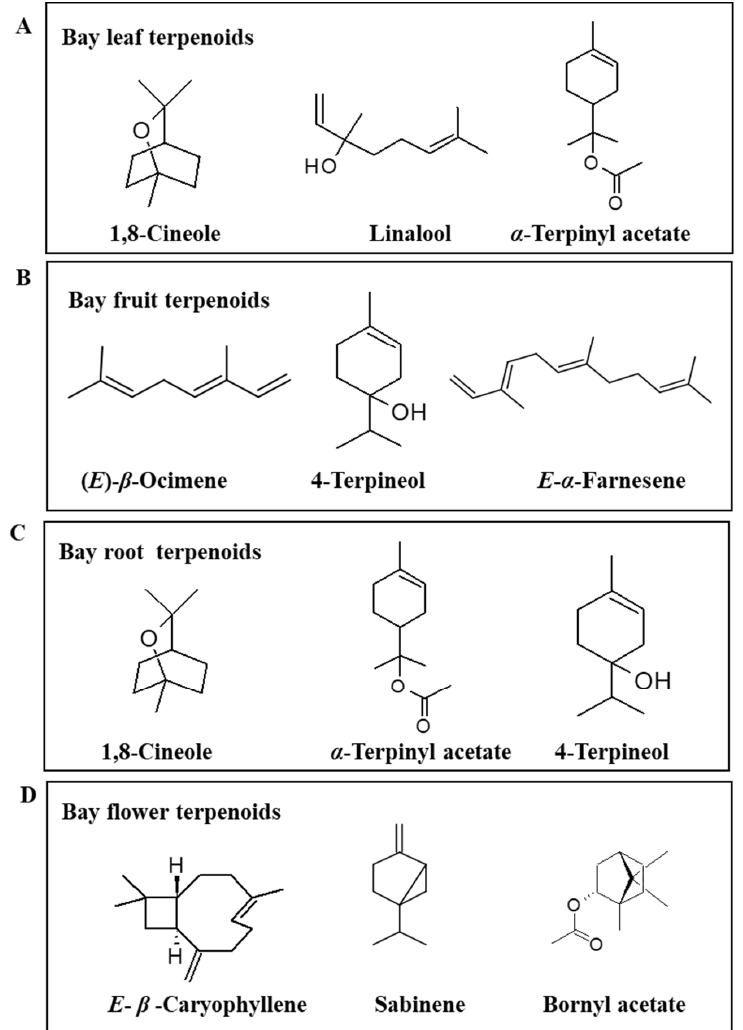
Figure 3. Representative terpenoids biosynthesized by bay ( Laurus nobilis L.). ( A ) Bay leaf terpenoids; ( B ) Bay fruit erpenoids. ( C ) Bayroot erpenoid; ( D ) Bayflower erpenoid. (VOCs) from leaves of young and old shoots of L. nobilis were significantly different. The